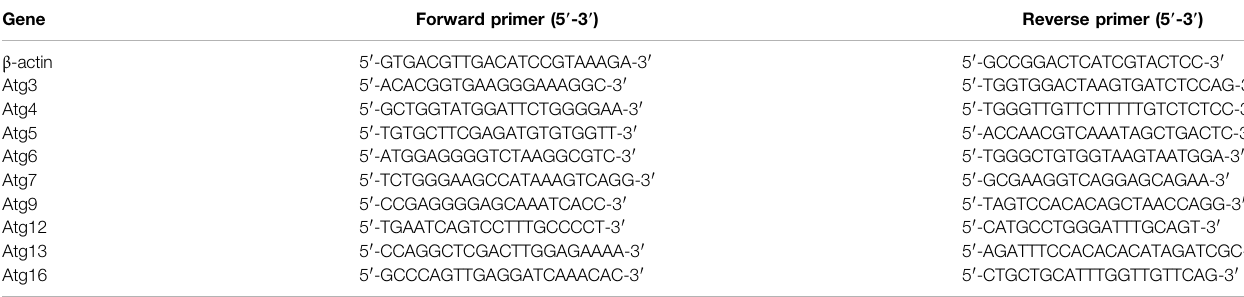
TABLE 1 | The primer sequences used in qPCR